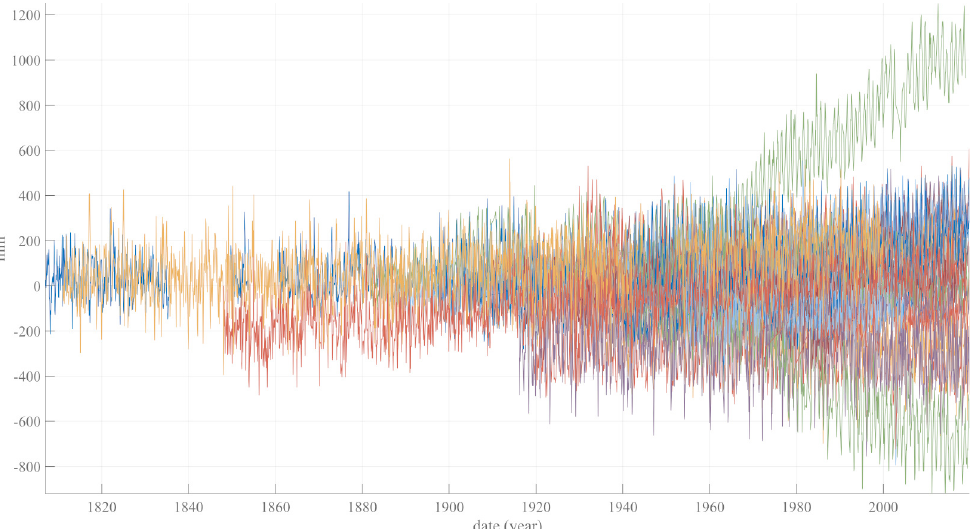
Figure 3. Superposition of data series from the 31 tide gauges listed in Table